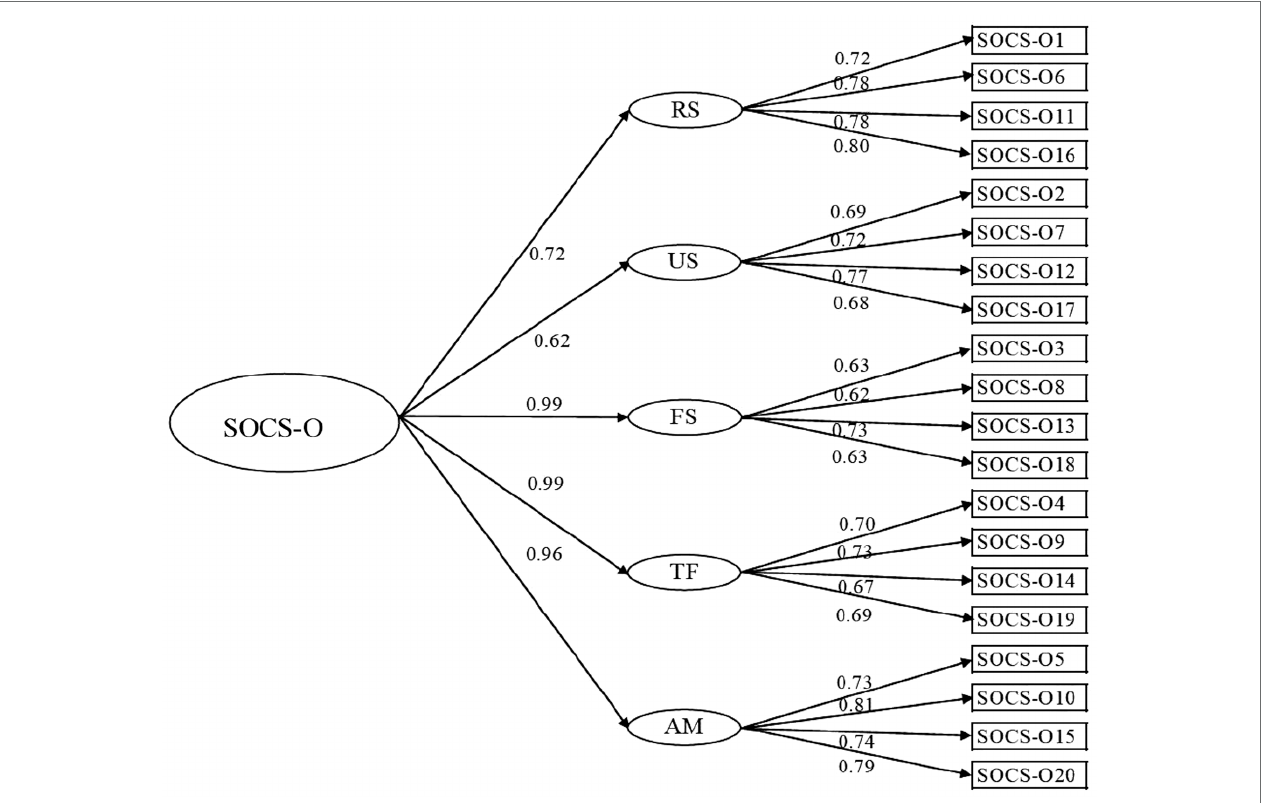
FIGURE 1 | Hierarchical five-factor model of the SOCS-O. Straight arrows: standardized item loadings. SOCS-O, Sussex-Oxford Compassion Scale for Others; RS, recognizing suffering; US, understanding the universality of suffering; FS, feeling for the person suffering; TF, tolerating uncomfortable feelings; and AM, acting or being motivated to act to alleviate